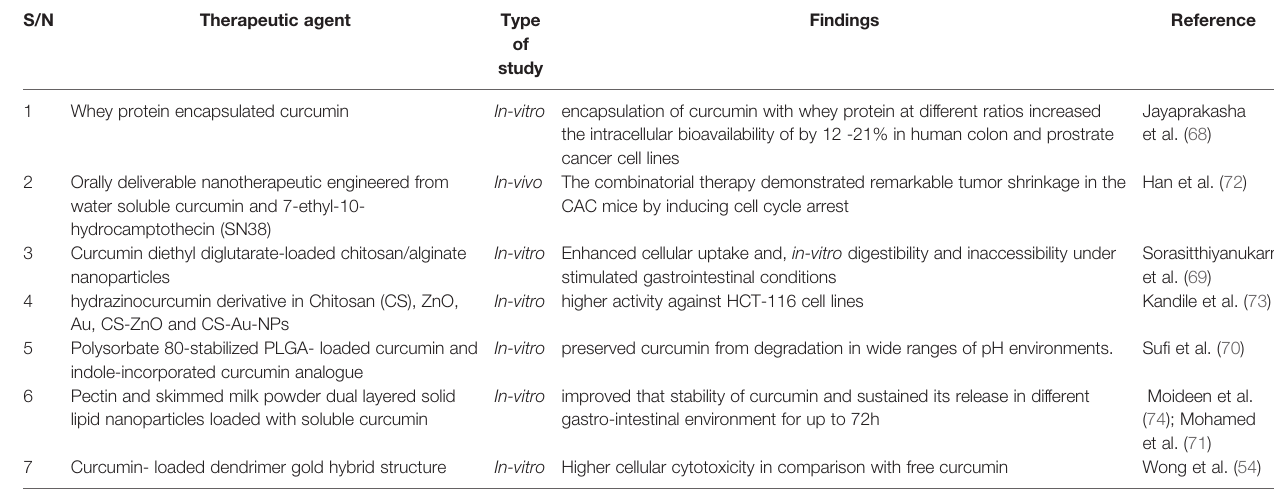
TABLE 3 | Curcumin-based nano formulations and structural analogues in the treatment of colorectal cancers in preclinical studies.